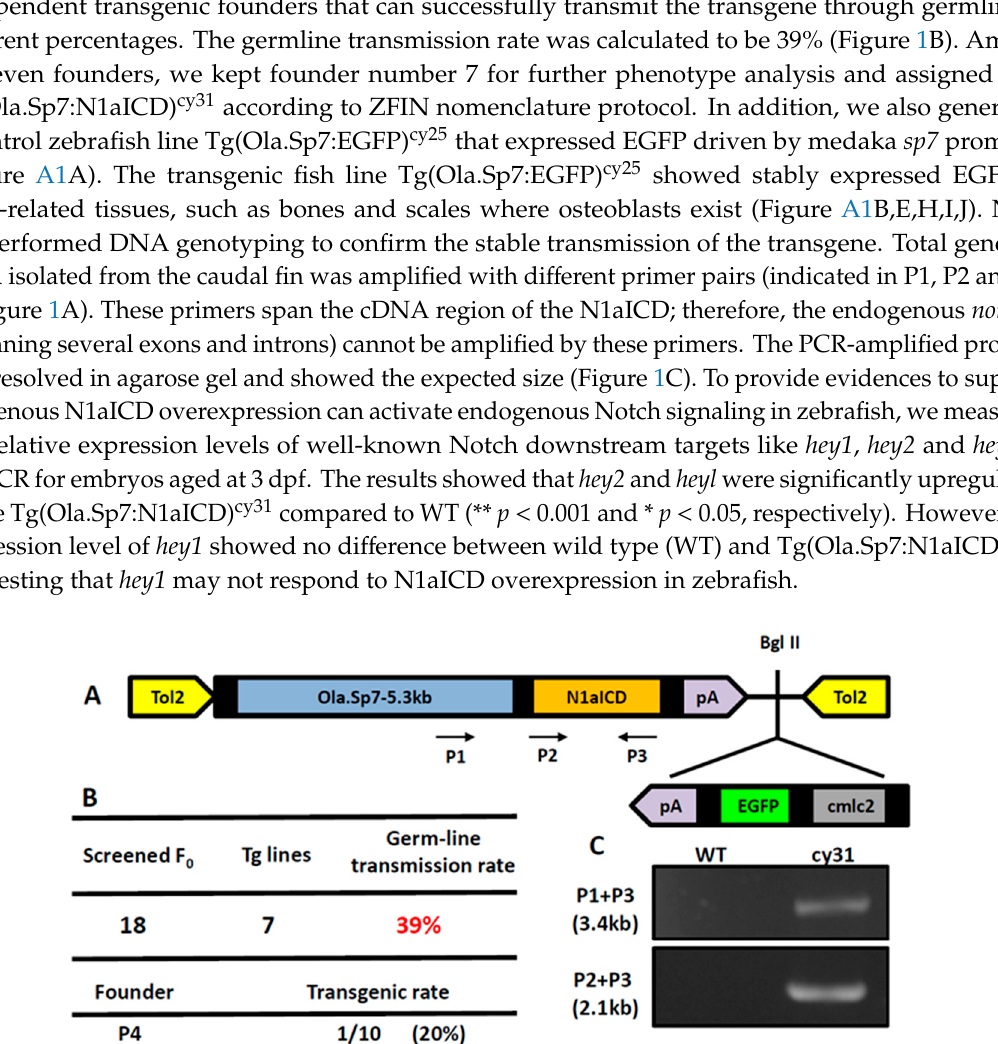
Tg(Ola.Sp7:N1aICD) cy31 according to ZFIN nomenclature protocol. In addition, we also generated a control zebrafish line Tg(Ola.Sp7:EGFP) cy25 that expressed EGFP driven by medaka sp7 promoter